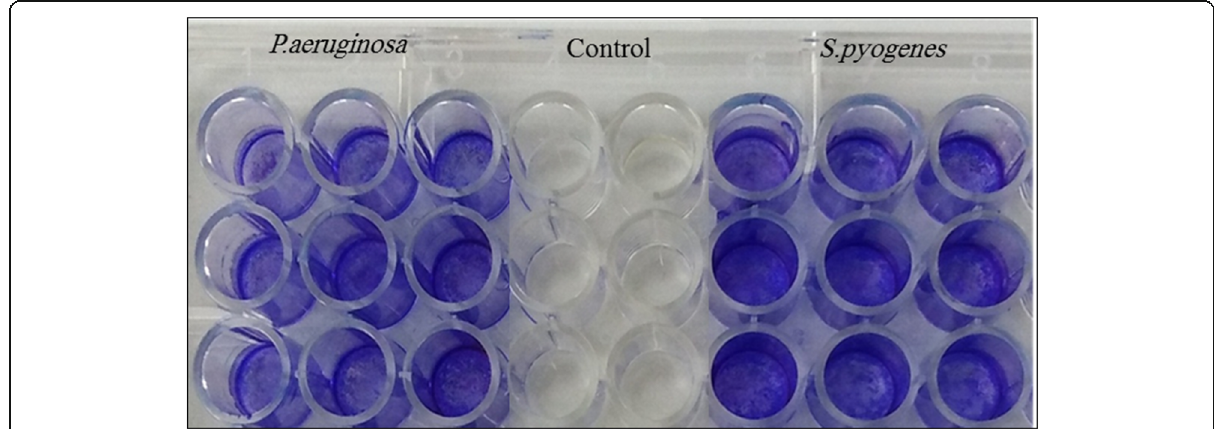
Fig. 1 P. aeruginosa and S. pyogenes biofilms. Biofilm formation qualitative assay in microtiter plate determined by using crystal violet. Biofilm was stained